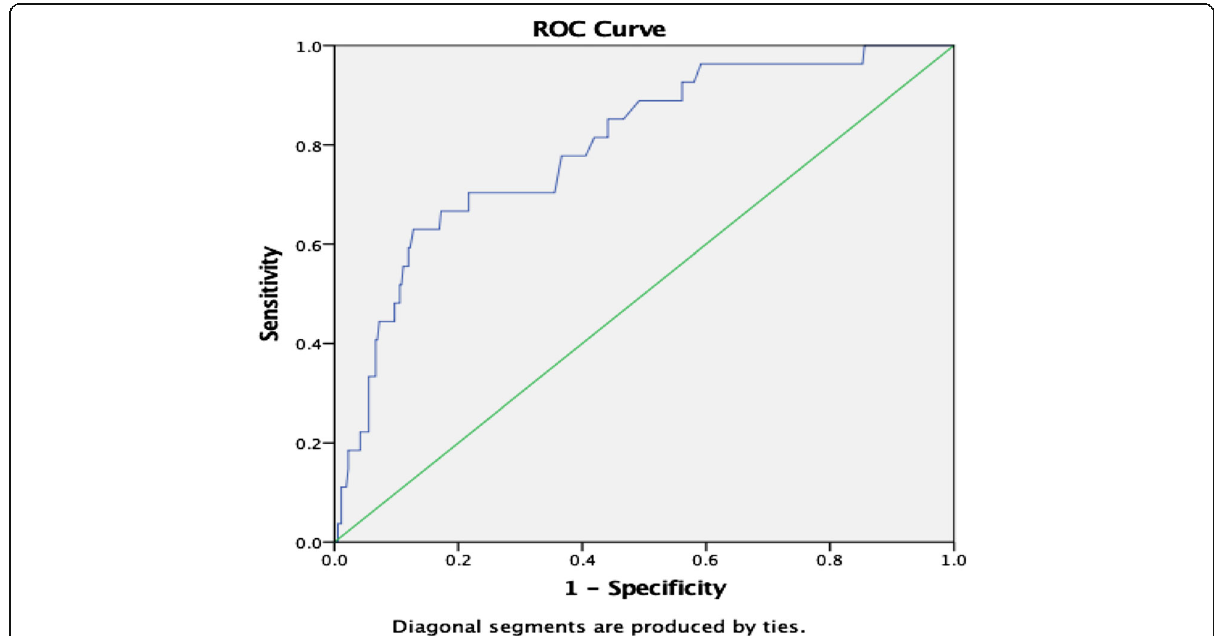
Fig. 2 Graphic representation of ROC curve for 24-h mortality